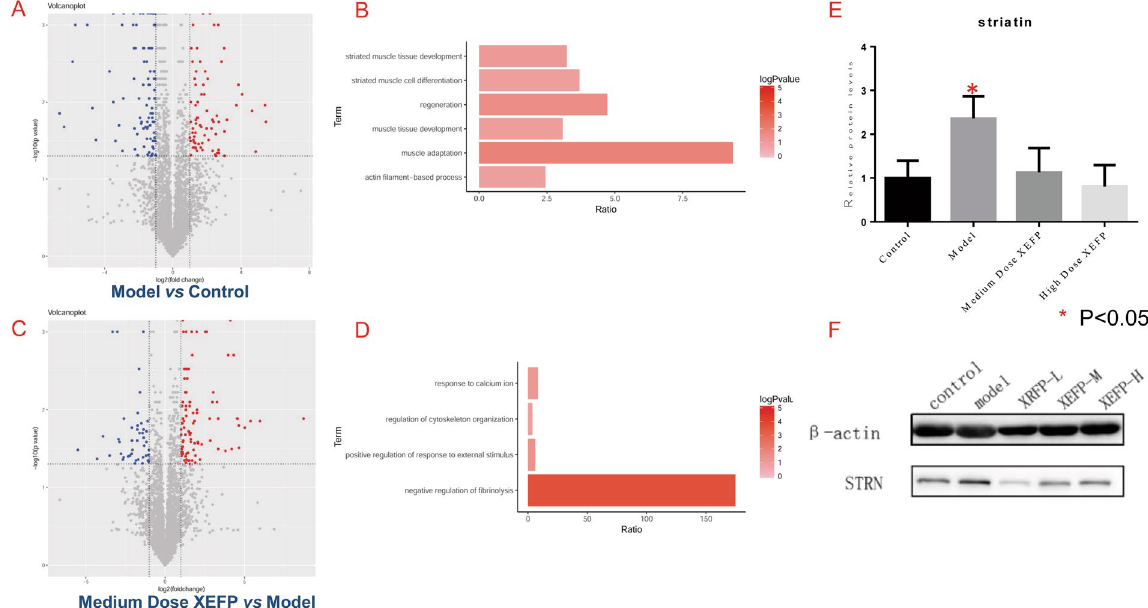
Figure 6. Proteomic investigation of the dynamic changes of proteins in FD and XEFP-treated rats, and discovery and verification of a new candidate target for the treatment of FD. ( A ) Volcano plot of dynamic changes of proteins in FD rats (model). ( B ) Biological process or molecular function of the proteins in model group with upregulated expression levels (p < 0.05) compared to the control. ( C ). Volcano plot of dynamic changes of proteins in FD rats after XEFP treatment. ( D ) Biological process or molecular function of the proteins of XEFP-treated FD rats with downregulated expression levels (p < 0.05) compared to model. ( E ) Proteomic quantitative analysis of the candidate target regulated by XEFP against FD in rats. ( F ) Western-blot verification of the new candidate target (striatin, STRN) for the treatment of FD. Blots were cropped from the same gel, but with different exposures (first striatin, then β -actin), and their full-length gels and blots are included in the Supporting Information file. XEFP-H, high-dosage XEFP. XEFP-M, medium-dosage XEFP. XEFP-L, low-dosage